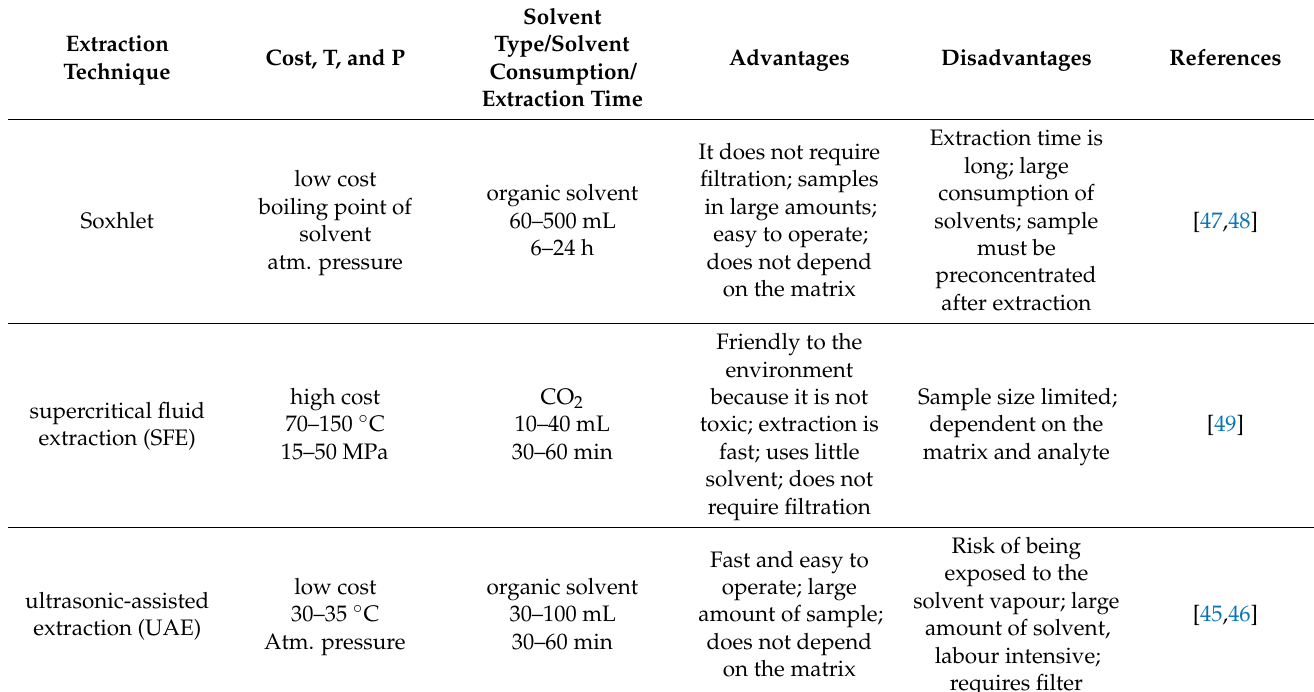
Table 7. Comparison of various extraction techniques for pesticides in solid